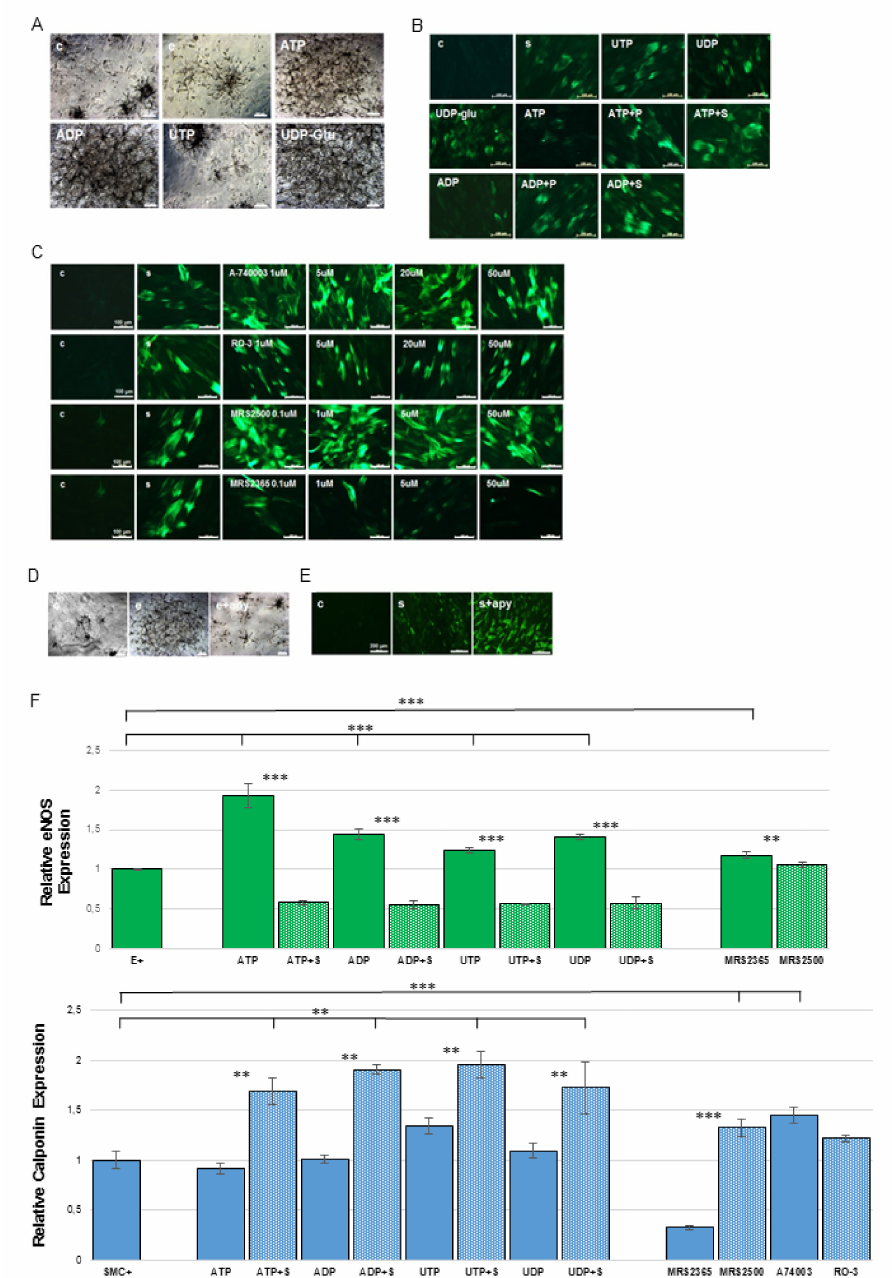
Figure 5. Natural and artificial P2 receptor agonists and antagonists influenced hMSC di ff erentiation towards endothelial cells and smooth muscle cells. Endothelial and smooth muscle cell di ff erentiated cells were evaluated by tube formation assay, eNOS and calponin staining separately. ( A ) Both ATP and UDP-glucose can significantly enhance tube formation. Scale bar 200 µ m; ( B ) ATP and ADP decreased calponin expression while PPADS and suramin reversed these e ff ects. Scale bar 100 µ m; ( C , F ) P2X7 artificial antagonist A74003 and P2Y1 antagonist MRS2500 enhanced the number of calponin-positive cells, P2Y1 agonist MRS2365 nearly inhibited smooth muscle cell di ff erentiation, while P2X3 antagonist RO-3 seemed to have no e ff ect. Scale bar 100 µ m; ( D ) Endogenous nucleotide released during the endothelial cell and smooth muscle cell di ff erentiation increased tube formation Scale bar 200 µ m; ( E ) while inhibiting smooth muscle cell di ff erentiation. Scale bar 200 µ m; ( F ) Quantification of endothelial and smooth muscle cell di ff erentiation and treatment with natural and artificial agonist and antagonists. ** p < 0.05; *** p < 0.001. (Immunofluorescent pictures see Supplementary Materials Figures S4 and